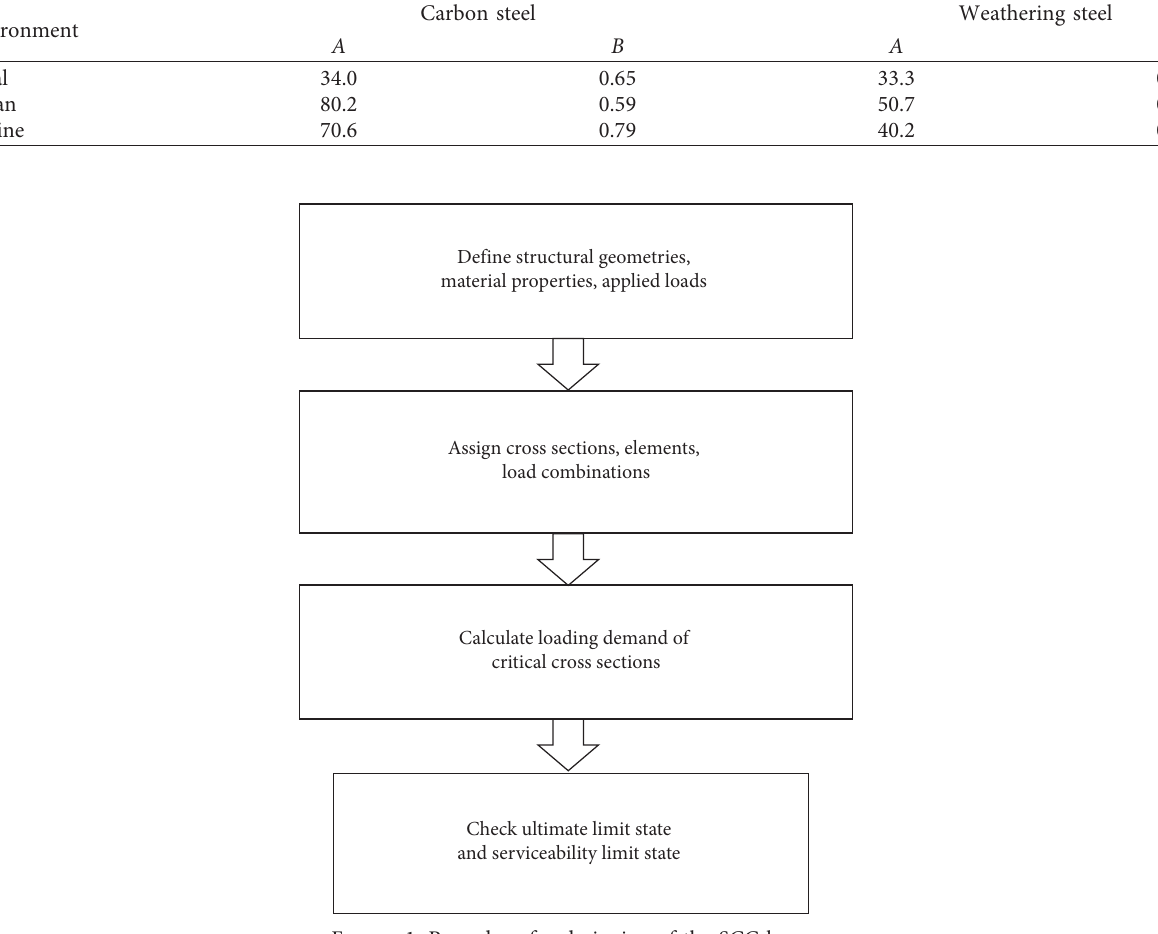
Figure 1: Procedure for designing of the SCC beam.